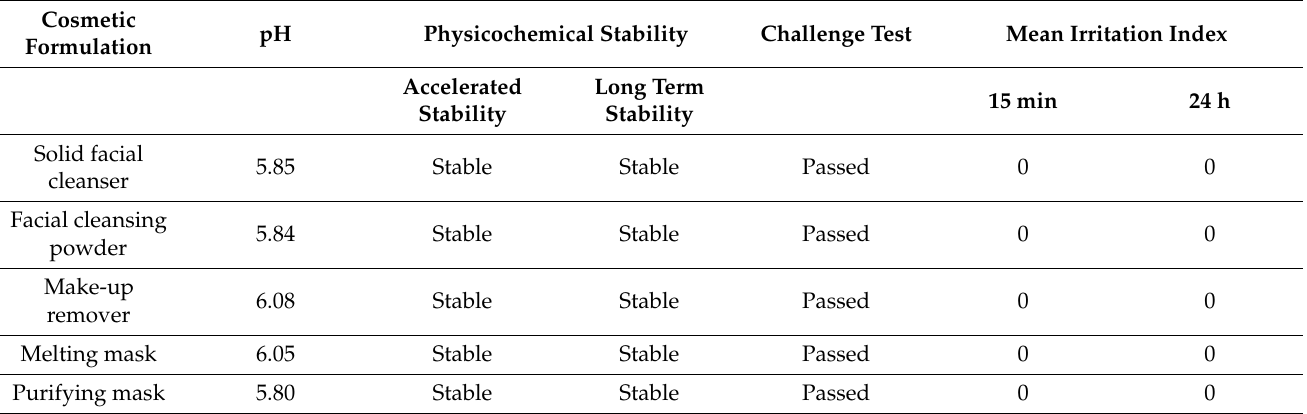
Table 9. Developed products with relative